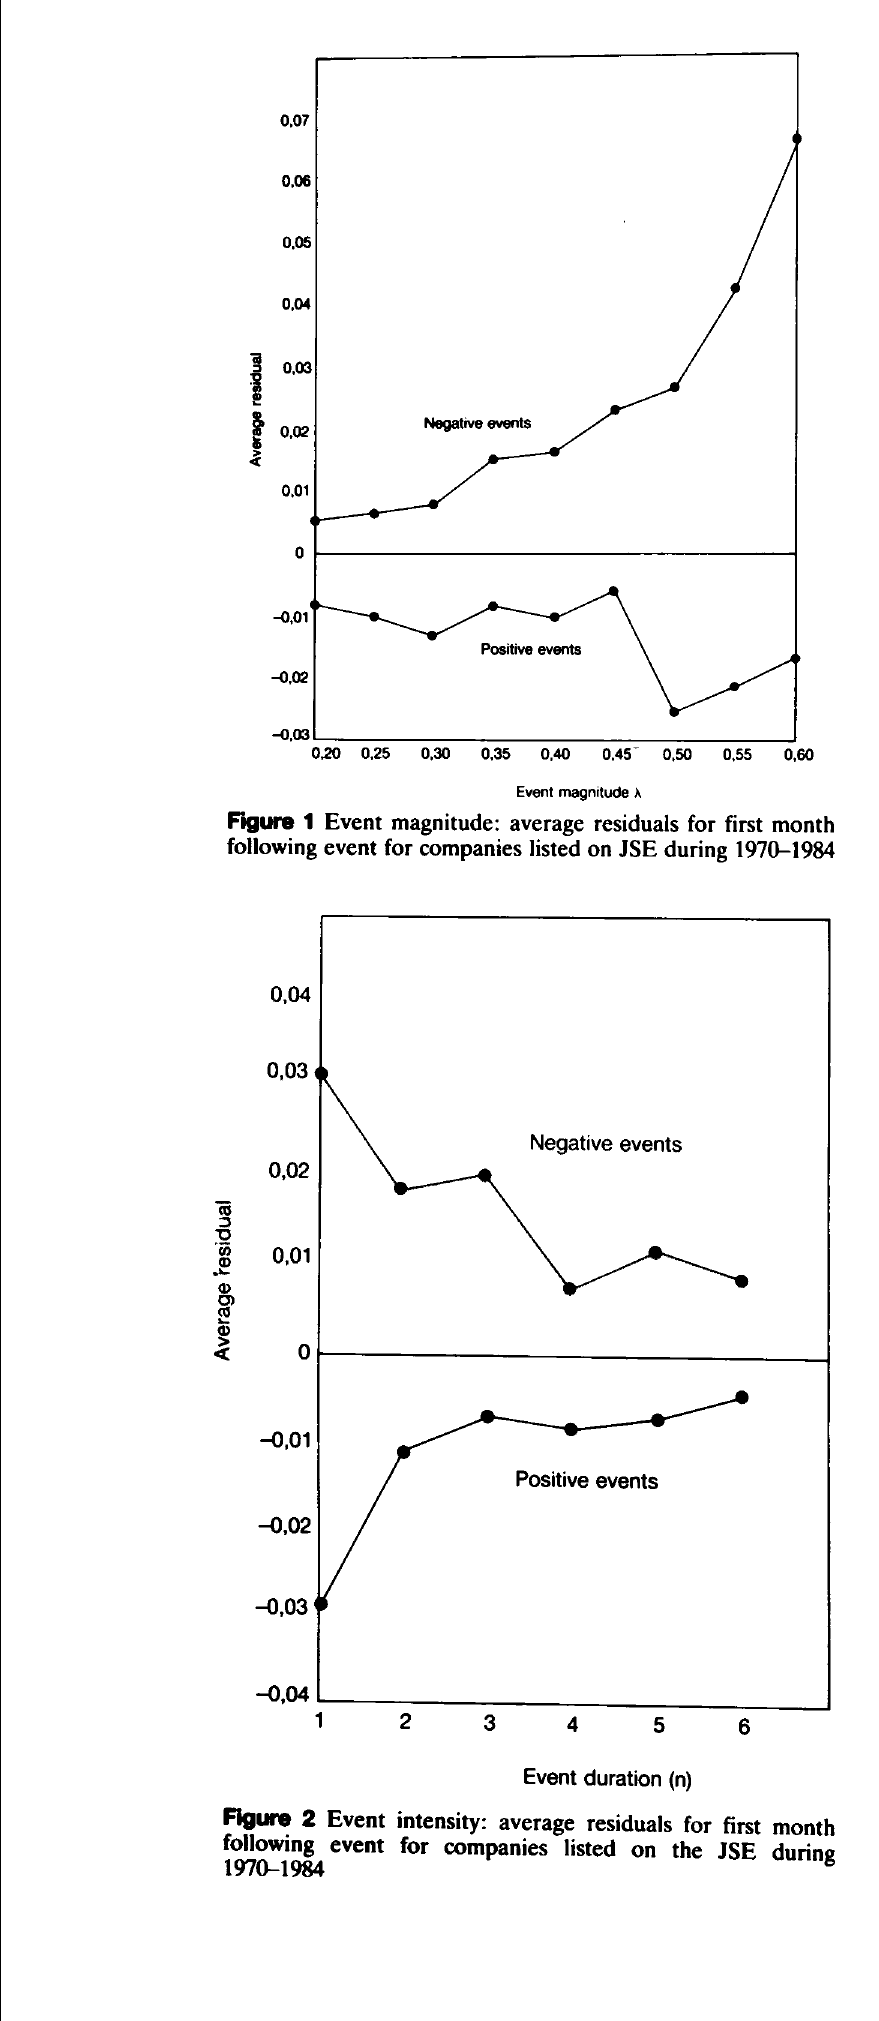
FigW'8 2 Event intensity: average residuals for first month following event for companies listed on the JSE during